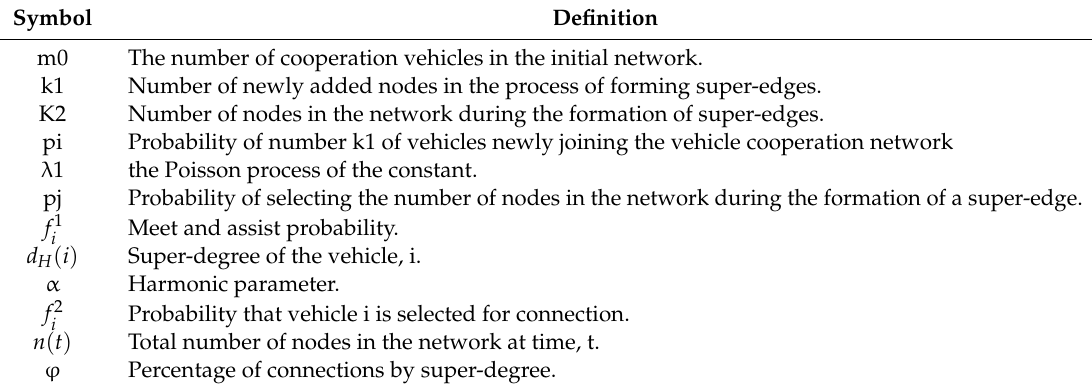
Table 1. Table of